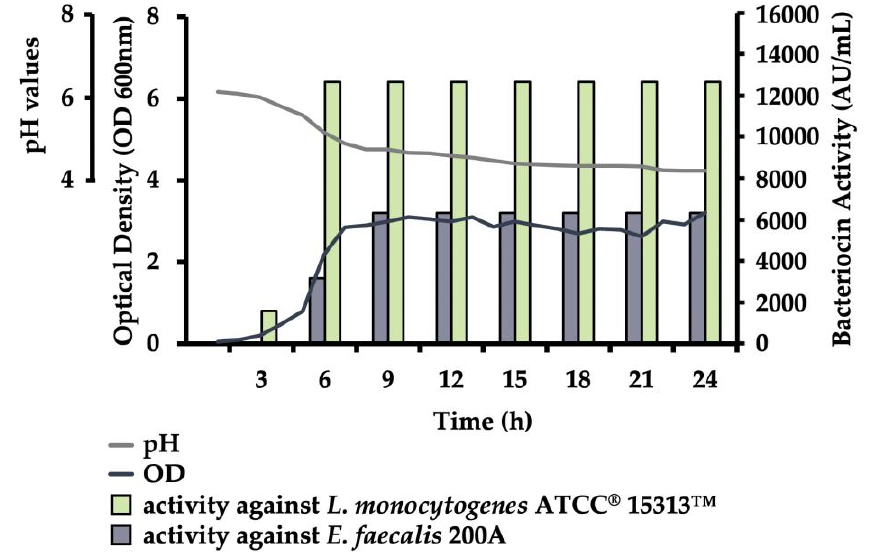
Figure 1. Kinetics of bacterial growth, acidification and bacteriocin production by E. faecium ST10Bz. All data represent an average of three repeats. The OD and pH values recorded in each experiment did not differ by more than 5% variation, and standard deviation values were not presented. Identical levels of bacteriocin production (AU/mL) were recorded for all three repeats.